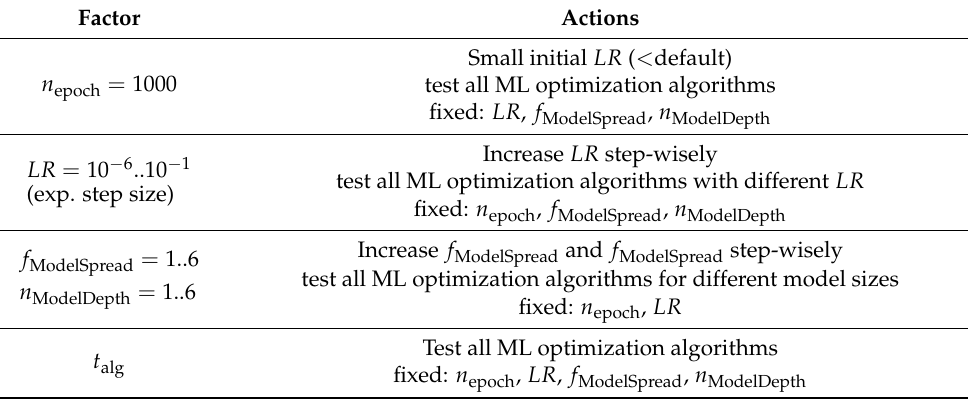
Table 3. Fractional Factorial Design Benchmark. Order and context of tuned parameters to optimize the prediction quality in explainable and recoverable manner [Abbreviations: LR = Learning Rate; ML = Machine